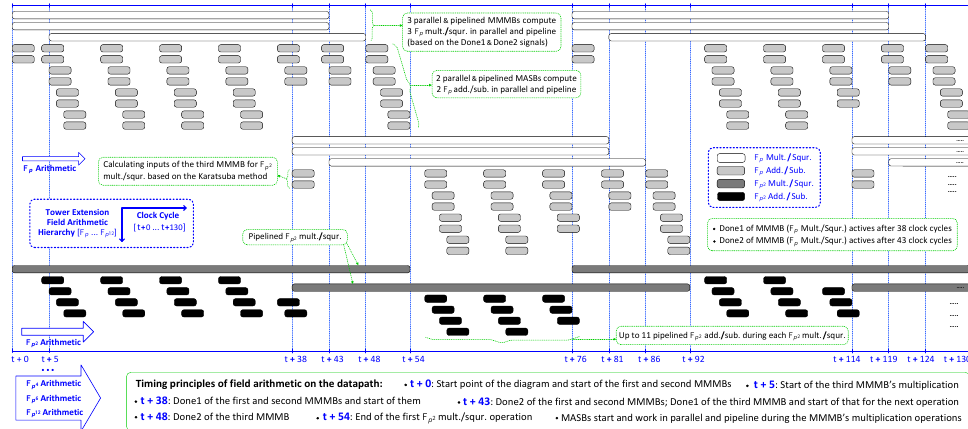
Figure 9: Timing diagram and scheduling technique of the tower extension field arithmetic operations (i.e., F